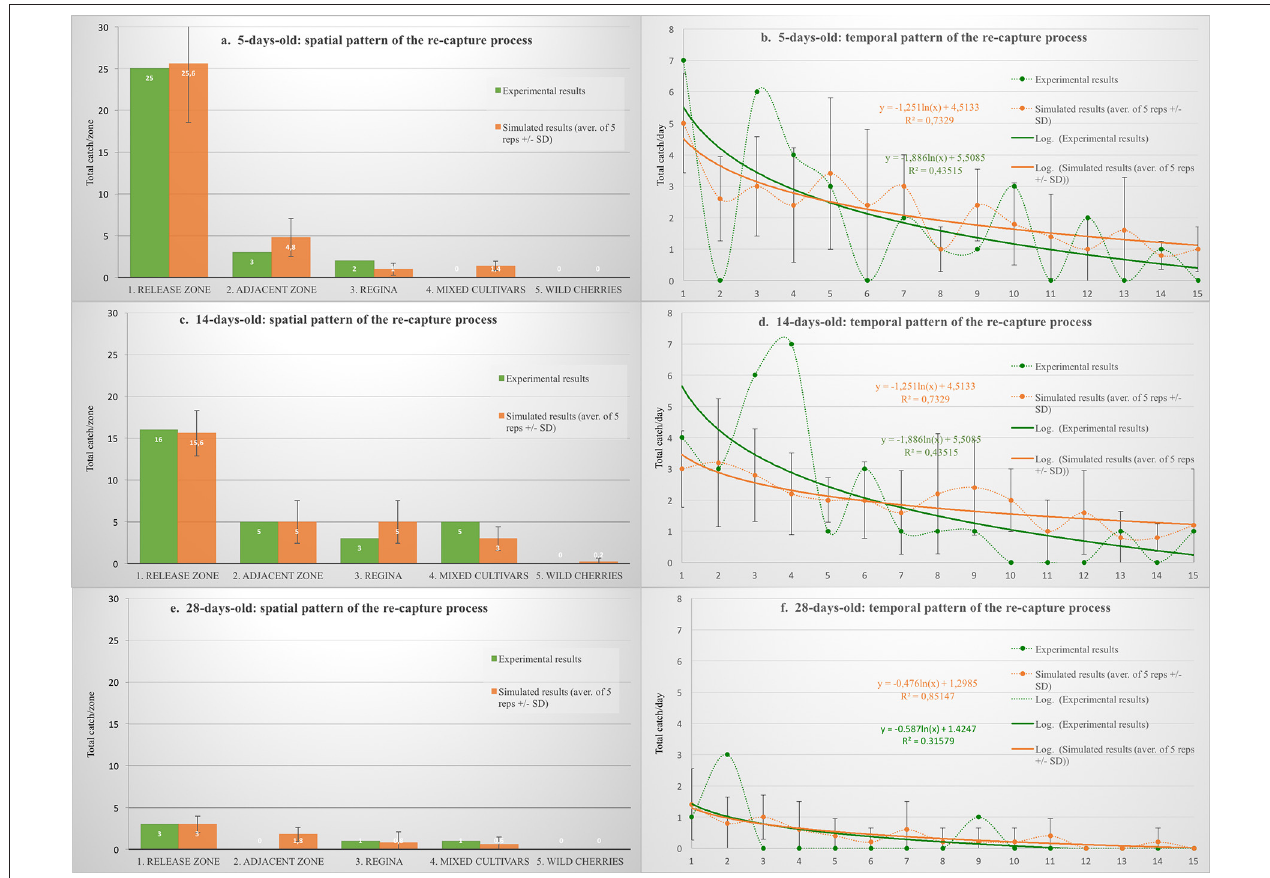
FIGURE 2 | The mark-recapture experiment: comparison between experimental vs. model-generated age-dependent recapture patterns.